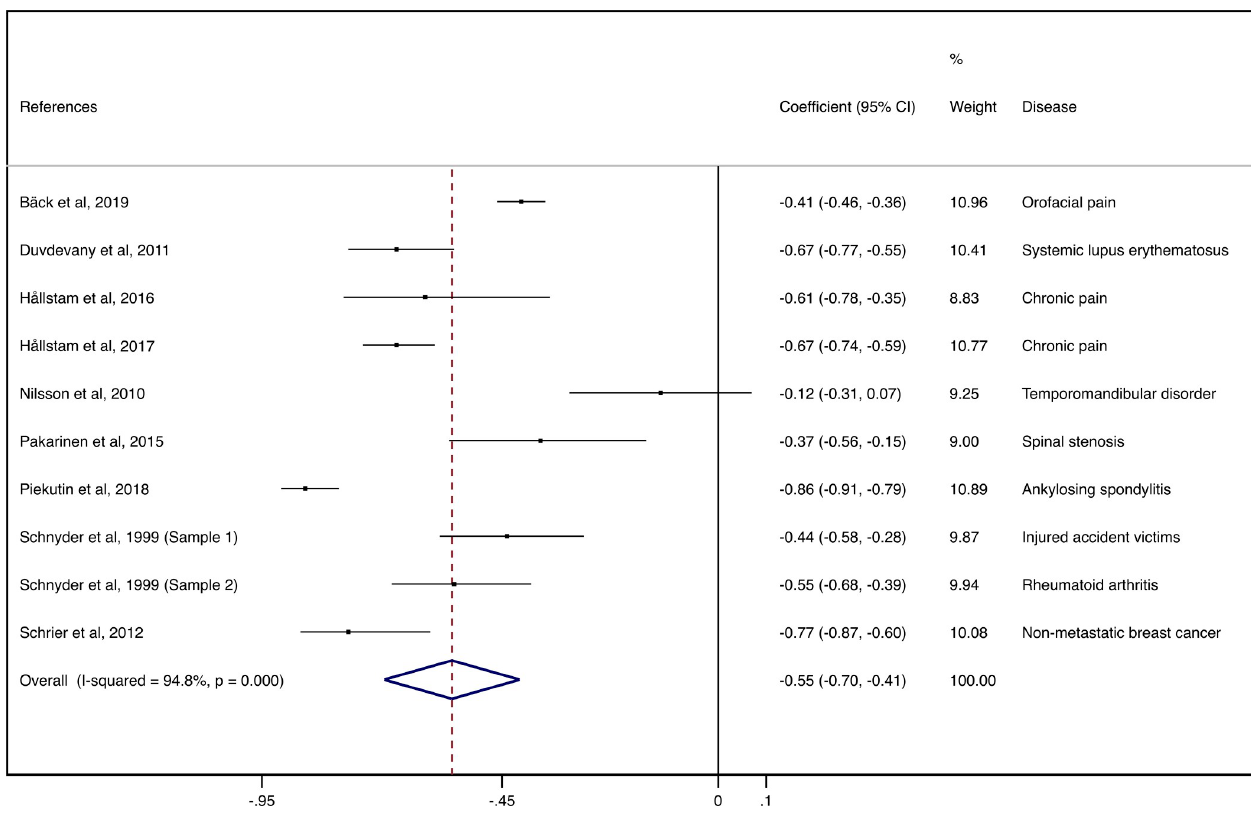
Fig 2. Pooled ES values for the association between depression and sense of coherence in patients with chronic pain.